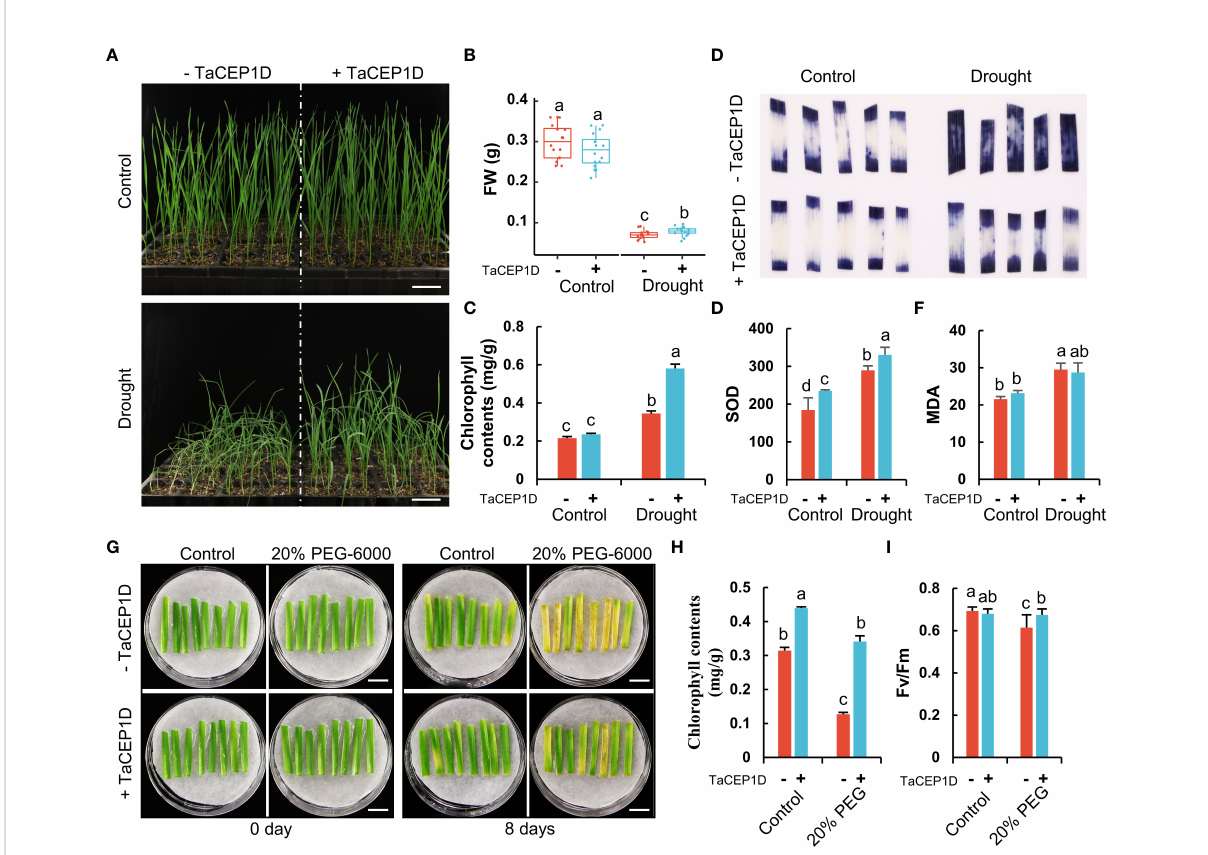
FIGURE 8 Exogenous application of TaCEP1D peptide altered drought response in wheat. (A) 2-week-old wheat plants treated with 0.5 µM TaCEP1D peptide for 4 days under control and drought condition. (B-C) Measurements of fresh weight (FW) and chlorophyll contents of wheat plants from (A) , respectively. (D-F) Nitroblue tetrazolium (NBT) staining of O 2- (D) , superoxide dismutase (SOD) activity detection (E) , measurement of molondialdehyde (MDA) contents (F) , respectively. Samples were harvested from the fi rst leaves of plants from (A) . (G) Detached leaves treated with 0.5 µM TaCEP1D peptide for 8 days under 20% PEG-6000 simulated drought stress. The fi rst leaves were cut from 2-week-old wheat plants cultured in Hoagland nutrient solution. (H-I) Measurements of chlorophyll contents and Fv/Fm of leaves from (G) , respectively. Sample size n = 16 in (B) , 3 in (C, E, F, H) , and 8 in (I) . All statistics analyses were performed three biological replicates. Different lowercase letters in (B, C, E, F, H, I) indicate statistically signi fi cant differences based on Student ’ s t- test ( p < 0.05). Bar = 5 cm in (A) , and 1 cm in (G)